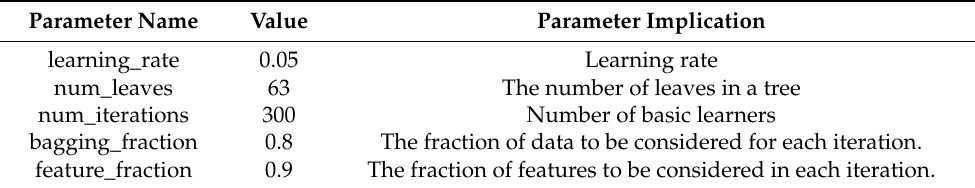
Figure 3. Training process of PUA-LightGBM model and histogram-based decision tree algorithm. DT—Regression Decision Tree; 𝑓 (cid:2919) (𝑥 )—Output of DT i ; ∑ 𝑓 (cid:3036) (𝑥(cid:4667) (cid:3041) (cid:3036)(cid:2880)(cid:2869) —final output of the PUA-LightGBM model. Table 1. The parameters of the LightGBM model.